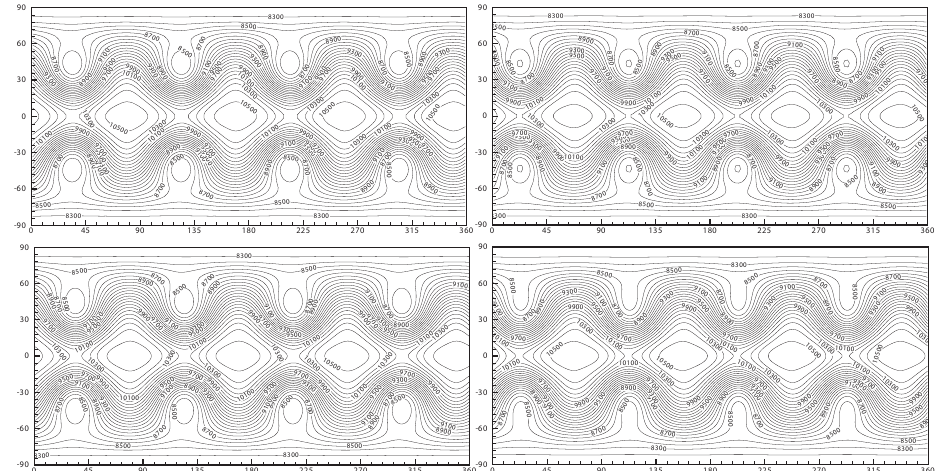
Figure 12. Numerical results of water depth for case 6 on grid G 12 at day 7 (top left), day 14 (top right) and on grid G 24 at day 7 (bottom left) and day 14 (bottom right).